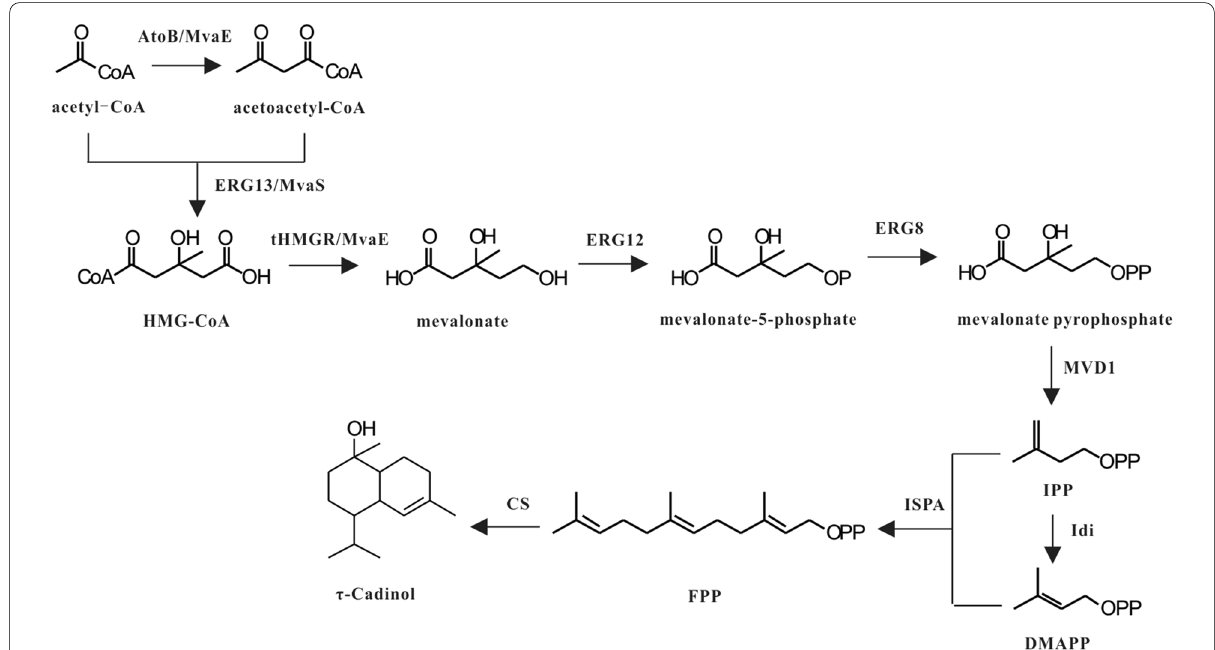
Fig. 1 Engineered pathway for the production of τ-cadinol from